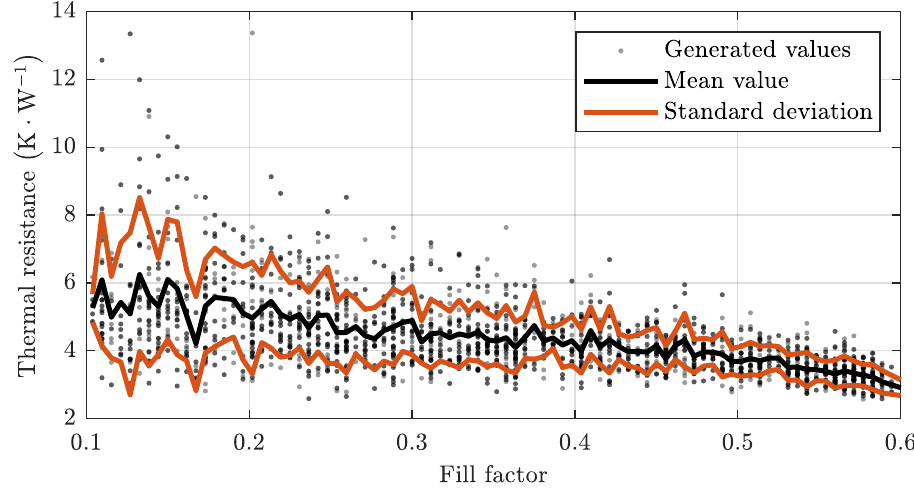
Figure 15. Thermal resistances R l , R r .